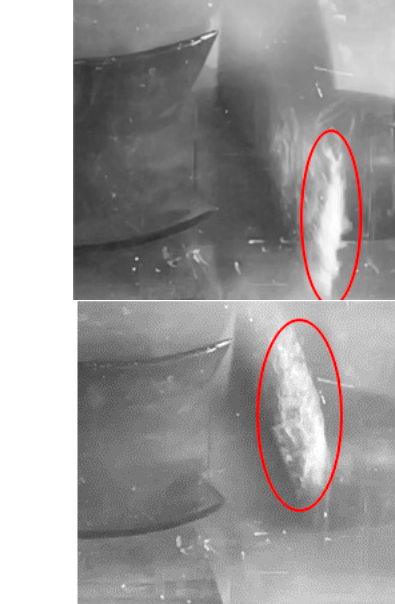
Figure 18. Acceleration scheme 3.